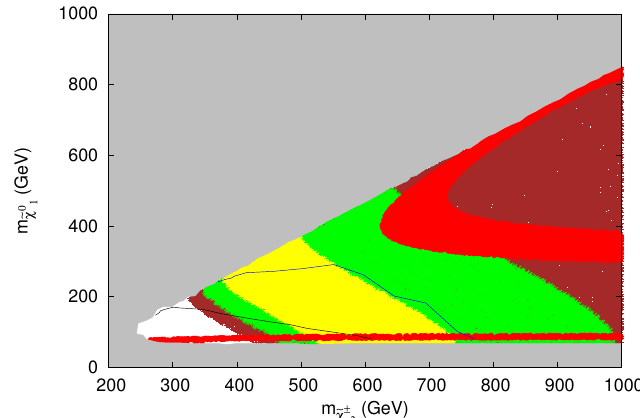
Figure 2 . Exclusion contours in the m Slepton (CLHHS ( f W )) model. The blue (black) line represents exclusion obtained by us ([10]) using the ATLAS 3 l + E= T search data from Run II (Run I). Colors and conventions are same as in (cid:12)gure 1.